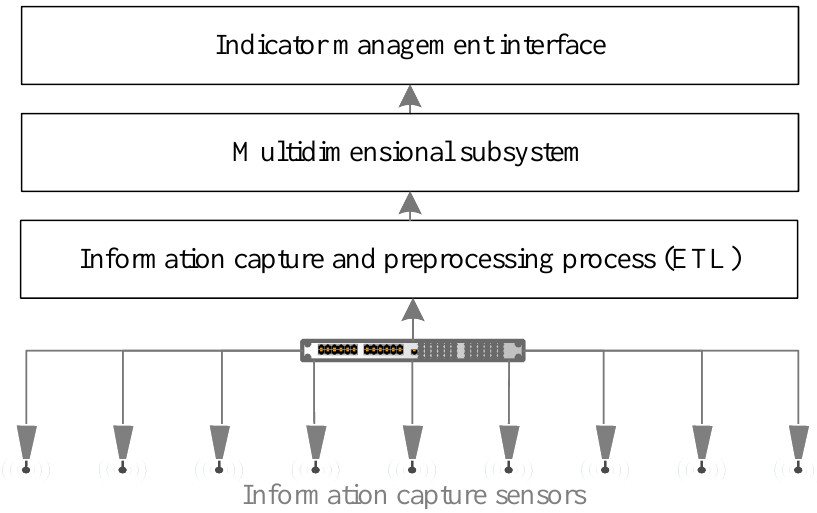
Figure 7. Outline of the online system for the monitoring and evaluation of environmental improve- ment plans (Extract, Transform and Load